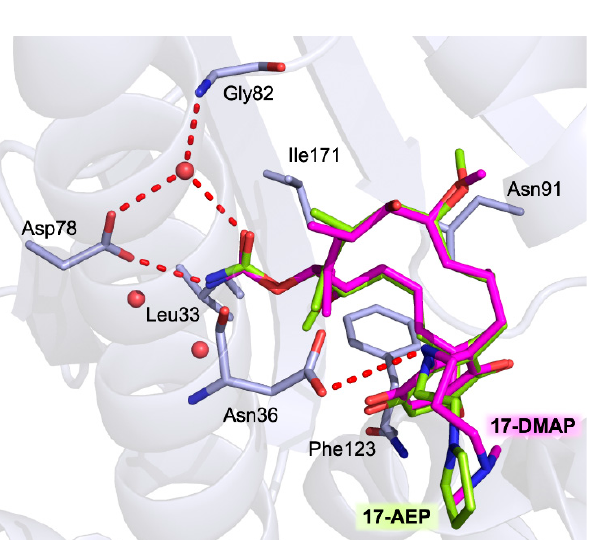
Figure 7. Active-site view of the superimposition between the 17-DMAP-geldanamycin (in sticks, magenta carbons) and 17-AEP-geldanamycin (in sticks, cyan carbons) in complex with Lm –NTD (yellow carbons) (PDB ids 3Q5J and 3Q5L, respectively). H-bonds are shown as red dashed lines, and water molecules as red spheres.